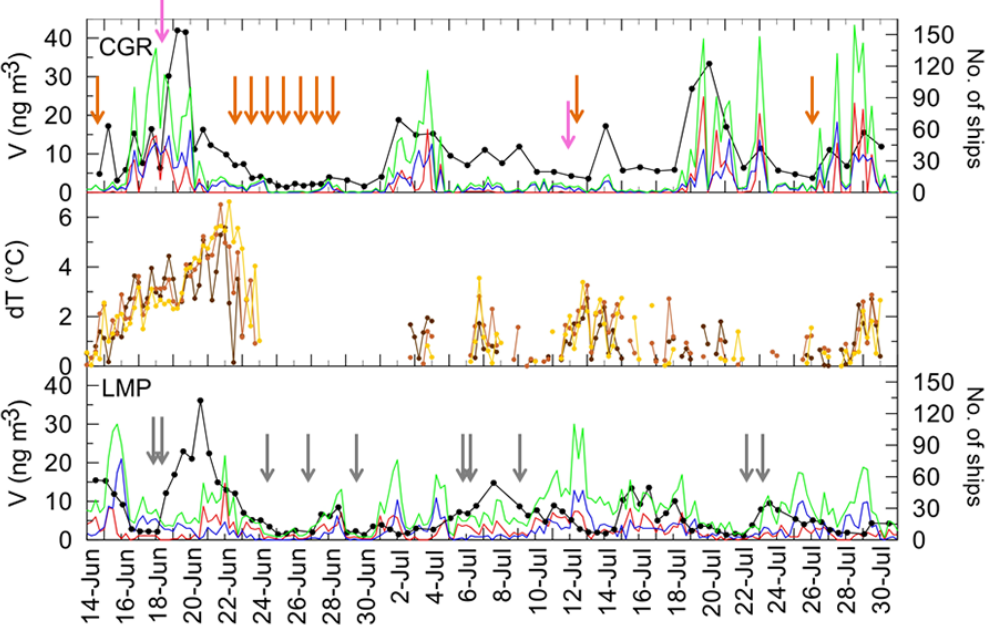
Figure 7. Time series of Vanadium concentration (black line with dots) and number of ships affecting the air masses sampled at CGR (upper panel) and LMP (lower panel). Green, red and blue lines indicate, respectively, the total number of ships and the number of merchant (i.e. cargo and tanker) and fishing vessels. The time evolution of the temperature inversion index (d T in the figure) at three different locations in the Straight of Sicily is shown in the middle panel; brown, red and yellow curves show the behaviour at sites A–C (see text). The orange arrows identify samples classified as crustal, based on the La-Ce-V concentration; pink and gray arrows identify samples with LCR > 1, possibly influenced by